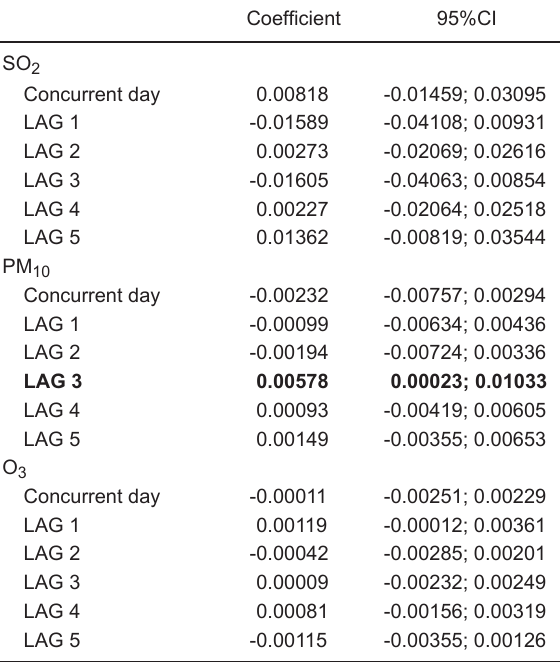
Table 3. Regression coefficients and 95% confidence interval (95%CI) according to lag structure for hospital admission due to cardiovascular disease, São José dos Campos, 2004-2006.